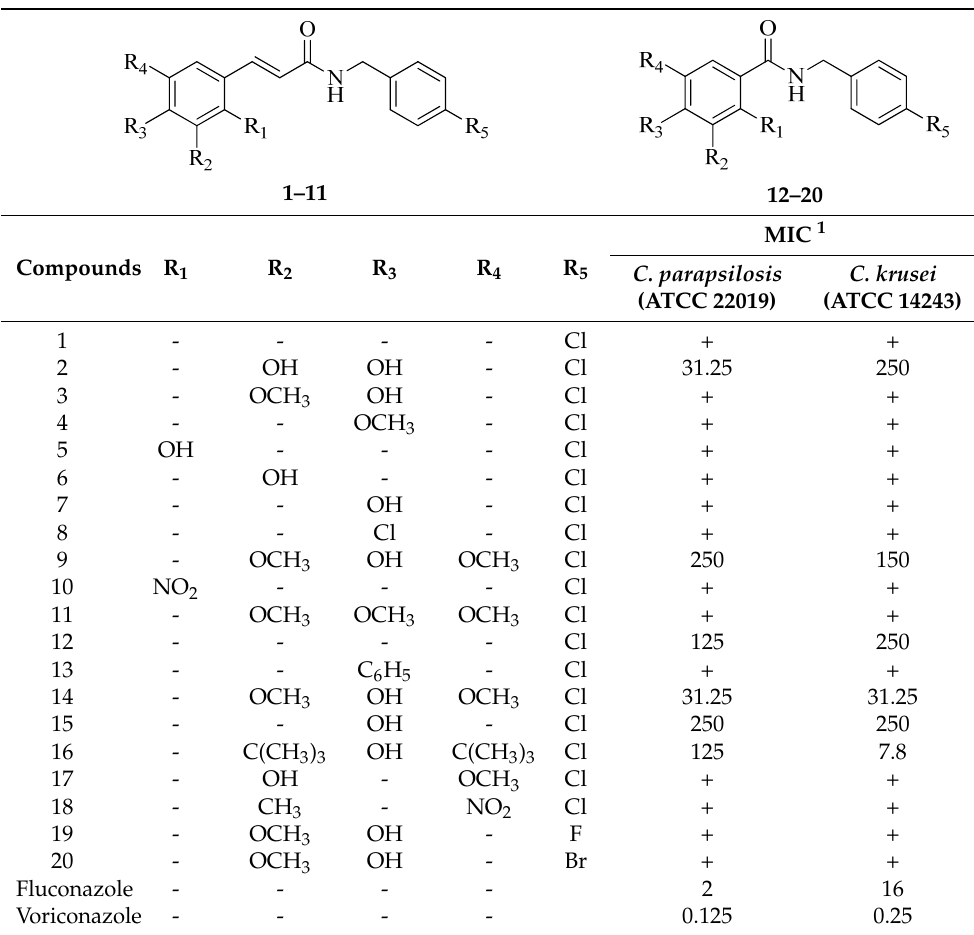
Table 1. Evaluation of MIC ( µ g/mL) of the amides derived from cinnamic and benzoic acids in the broth microdilution assay.